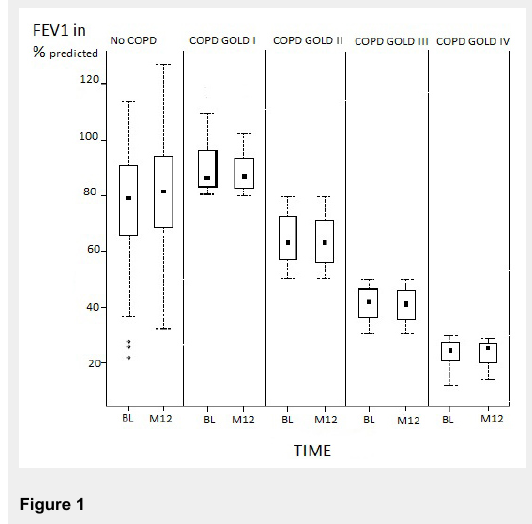
Trend of FEV 1 over 12 months. Comparison of average FEV 1 predicted in different COPD groups at BL and after 12 months. Abbreviations: FEV 1 , forced expiratory volume in 1 second; COPD, chronic obstructive pulmonary disease; GOLD, Global Initiative for Chronic Obstructive Lung Disease.